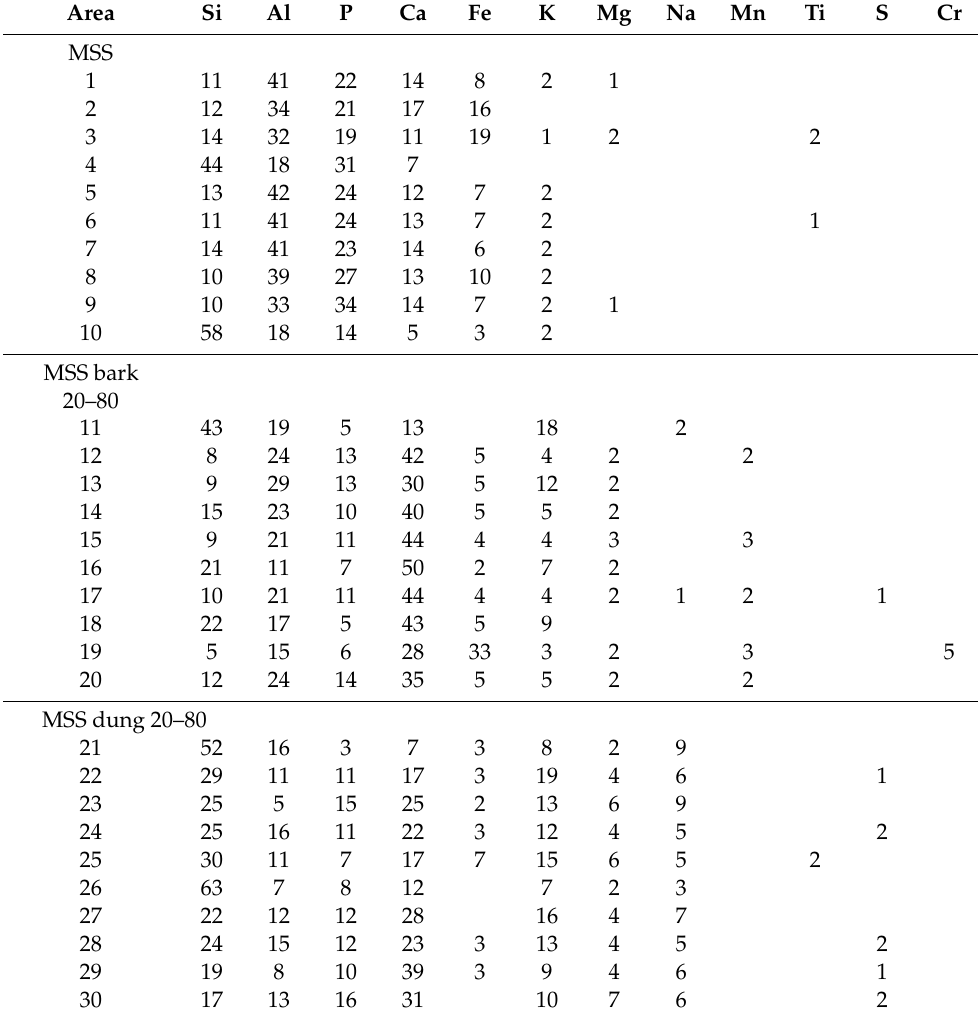
Element distribution in marked areas in Figure 6 given as wt.% on a carbon- and oxygen-free